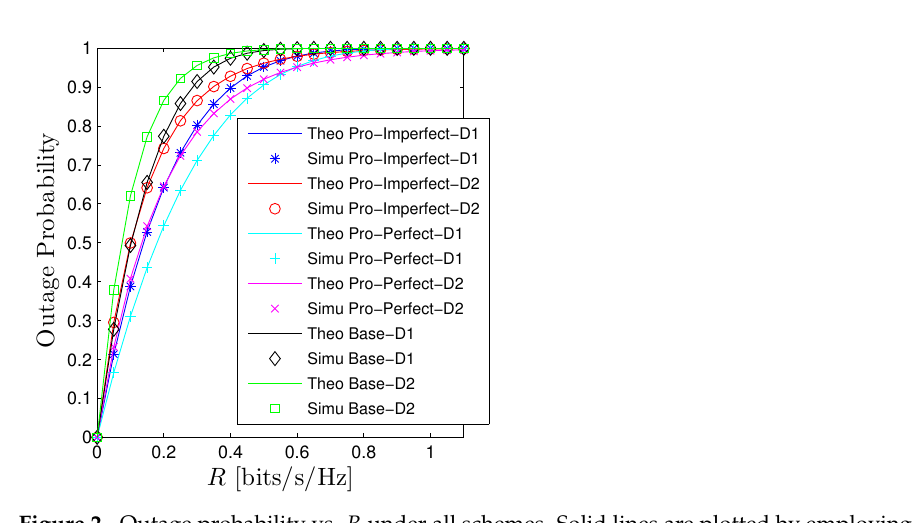
Figure 2. Outage probability vs. R under all schemes. Solid lines are plotted by employing (15)–(17) while markers are Monte Carlo simulation.